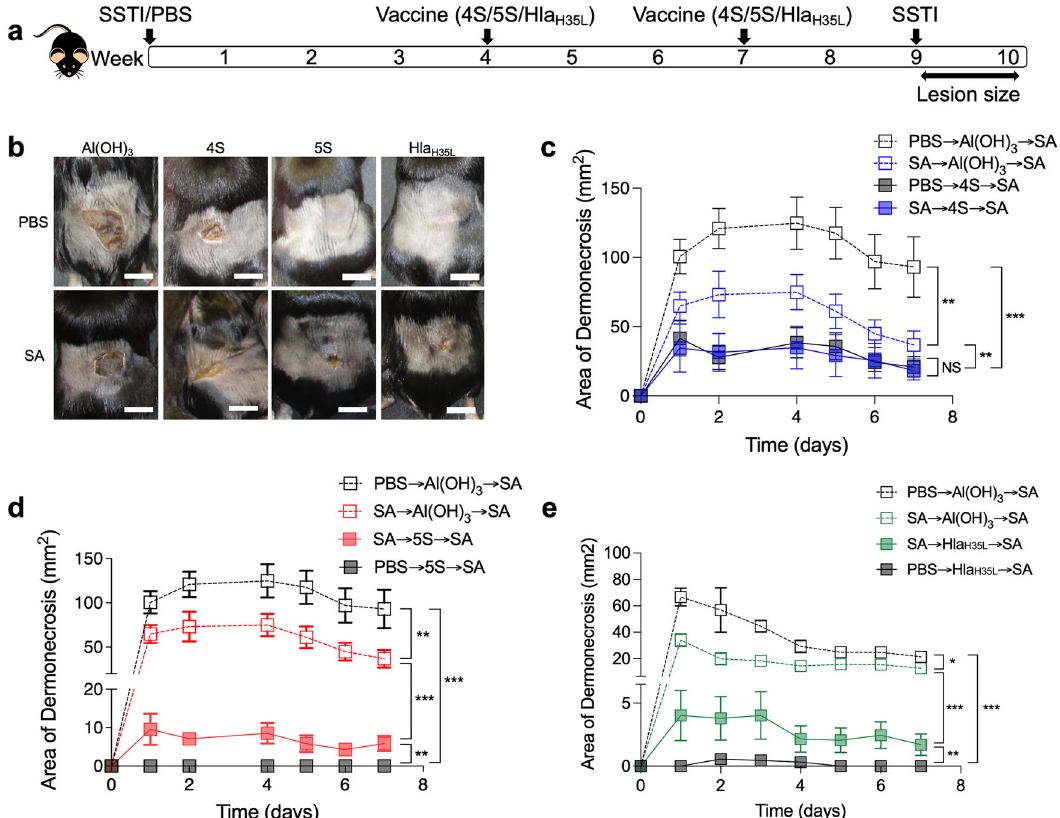
Fig. 1 S. aureus SSTI interferes with the ef fi cacy of HlaH35L vaccine-mediated protection against dermonecrosis. a Experimental model: C57BL/6 mice were infected with S. aureus (SA) SSTI followed by vaccination with “ 4S ” (LukE, LukS-PV, SplB, SspB), “ 5S ” (4S + Hla H35L ), or Hla H35L , followed by secondary SSTI. Aluminum hydroxide (Al(OH) 3 ) was used as an adjuvant; Al(OH) 3 group received the adjuvant alone. b Representative skin lesions on day 2 post-infection. Scale bar = 10 mm. c Prior SSTI had no impact on the ef fi cacy of 4S vaccination. d Mice that received SSTI prior to 5S vaccination (SA → 5S → SA) had larger dermonecrotic skin lesions, compared with naïve 5S-vaccinated mice (PBS → 5S → SA). e Mice that received SSTI prior to Hla H35L vaccination (SA → Hla H35L → SA) had larger dermonecrotic lesions compared with naïve Hla-vaccinated mice (PBS → Hla H35L → SA). N = 5 mice/group; 1 representative experiment of at least 3 repeats is presented. Data are presented as mean ± SEM and were analyzed using two-way ANOVA with repeated measures and Tukey ’ s post-test. * indicates p < 0.05; ** p < 0.01; *** p < 0.001; NS not signi fi